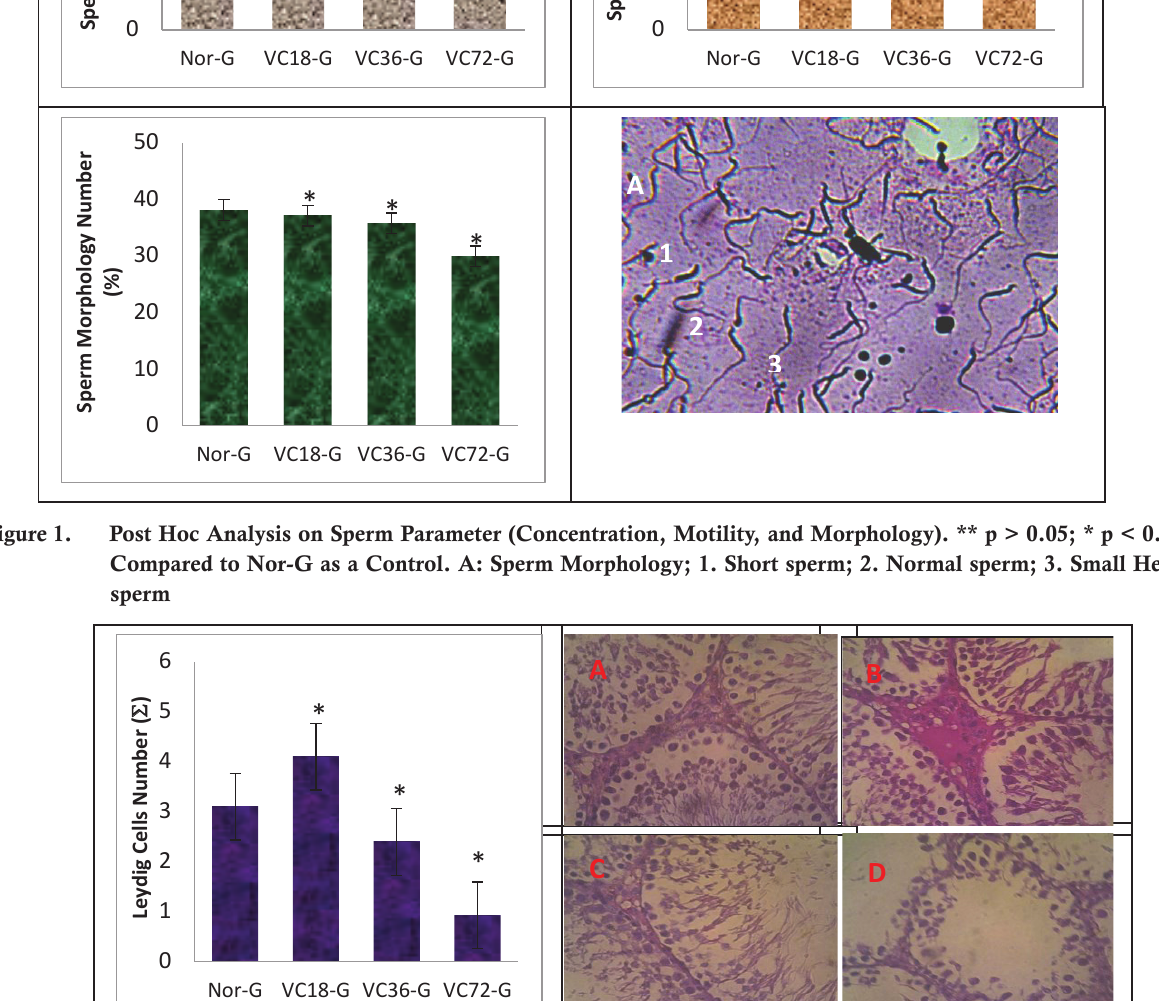
Figure 3. Sertoli Cells Number in each Group. A: Nor-G; B: VC-18-G; C: VC36-G; D: VC72-G. * p < 0.05 Nor-G as a control Discussion The results of this study showed the administration of vitamin C with a dose of 18 mg/day or equal to 1000 mg in human could increase the Leydig and Sertoli cells number in male wistar rats. The results of this study are similar to studies conducted by Takhshid et al. which stated that the administration of 20 mg/kg/day vitamin C for 10 days in rats induced with pesticides Endosulfan, showed improvement in testicular cells following oxidative stress (Takhshid et al. , 2012). The results of this study also aligned with the study conducted by Mazloom et al., which showed that the administration of 1000 mg/day